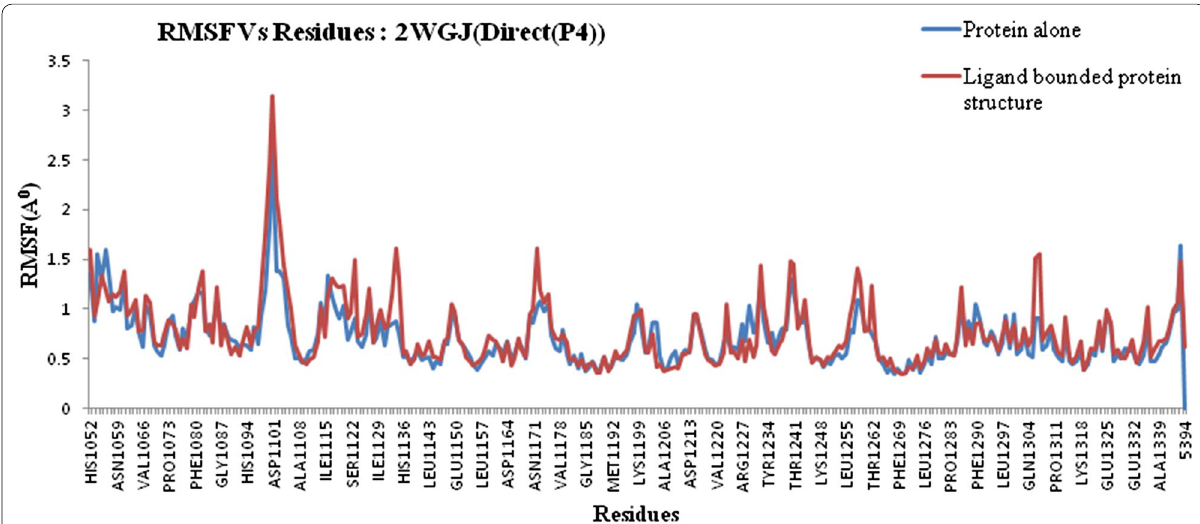
Fig. 6 RMSF graph based on ligand-free protein and ligand bounded protein complex of C-MET protein